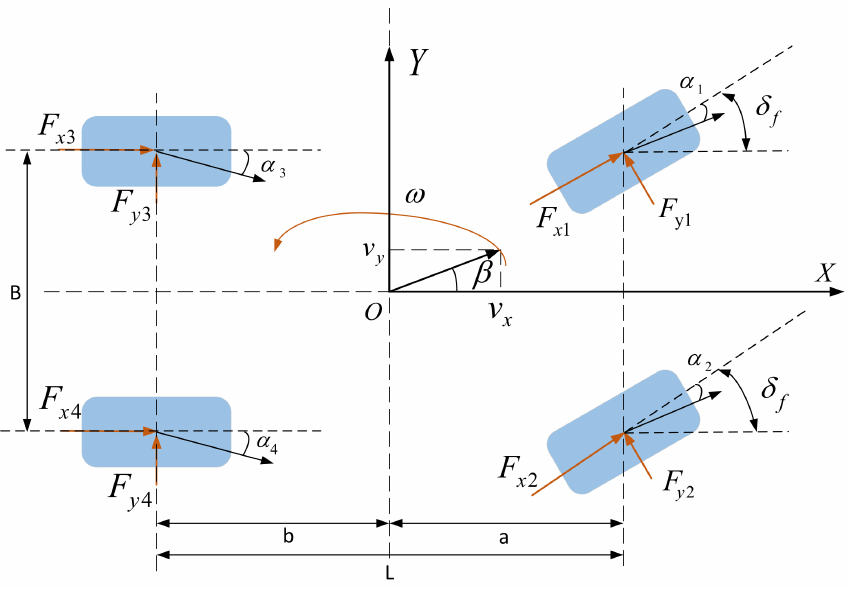
Figure 2. 7-DOF vehicle